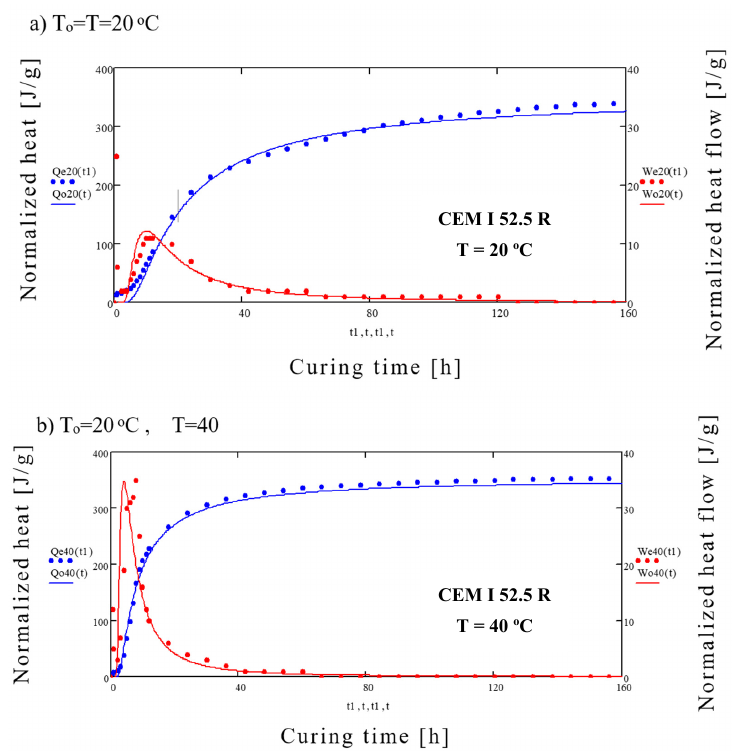
Figure 9. Comparison of experimental and calculated results of normalized heat and heat flow for the CEM I 52.5 R cement ( a ) for T = 20 ◦ C, ( b ) for T = 40 ◦ C. Similar analysis was performed for blastfurnace slag, results of which are presented in Figure 10.